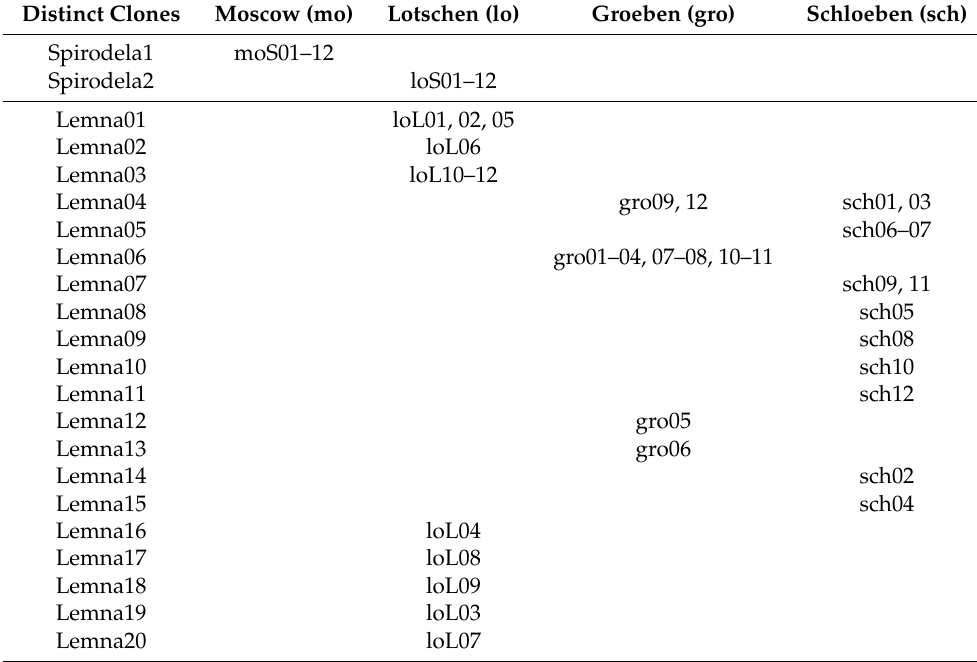
Table 2. Distinct clones of the species Spirodela polyrhiza and Lemna minor and their origin by collected samples from ponds in Moscow, Lotschen, Groeben and Schloeben. For further explanations, cf. Table